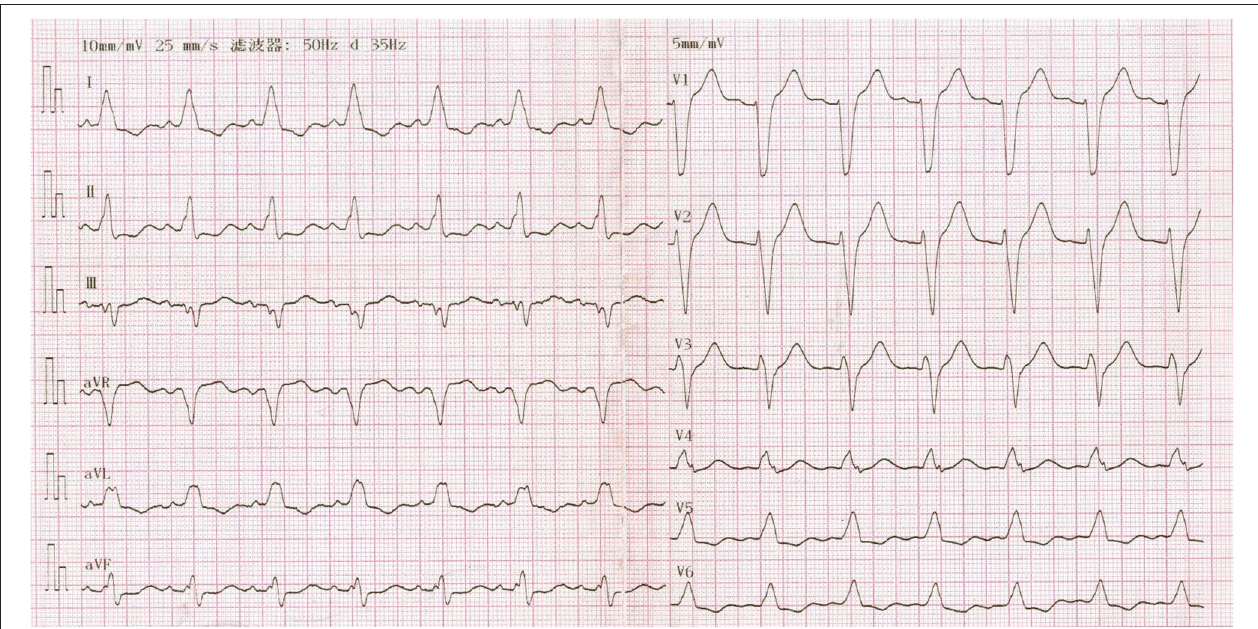
FIGURE 1 | Twelve-lead electrocardiogram showing complete left bundle branch